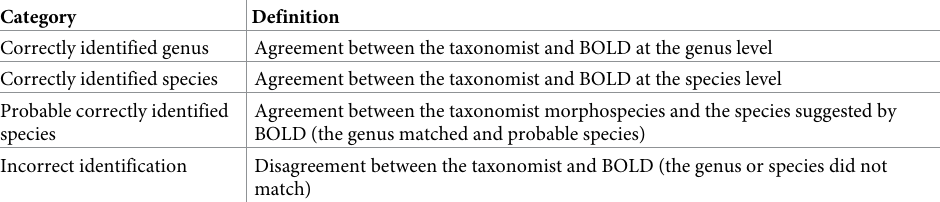
Table 1. List of categories used by the taxonomist to define the identification results suggested by BOLD with the Scarabaeinae subfamily.